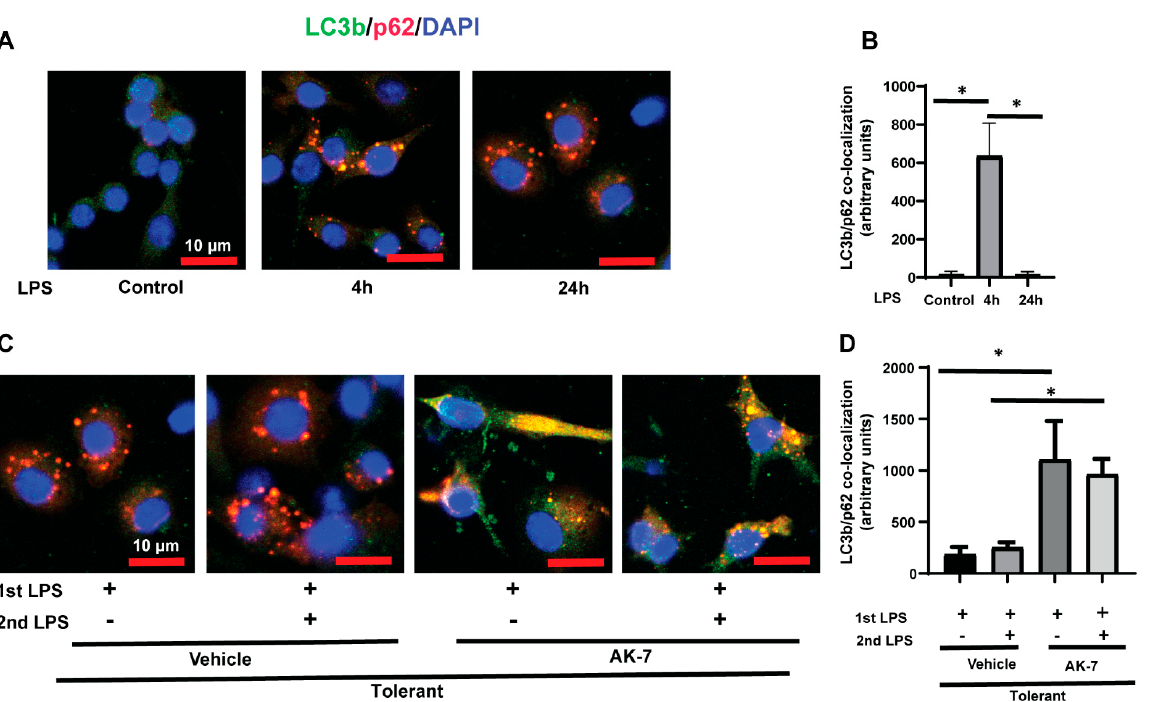
Figure 5. Elevated interaction of LC3b and p62 in sensitive but not tolerant macrophages. Stearic acid (free fatty acid: FFA)-exposed sensitive and tolerant RAW264.7 cell macrophages (RAW) were stimulated with or without LPS as indicated. ( A ) Representative Images of LC3b (green) and p62 (red) double immunostaining (yellow) in FFA-exposed sensitive and tolerant RAW cells following LPS stimulation as indicated. The yellow color indicates colocalization of LC3b and p62. ( B ) Fluorescence quantification of LC3b and p62 double immunostaining (yellow) in FFA-exposed sensitive and tolerant RAW cells. ( C ) FFA-exposed tolerant RAW cells were treated with SIRT2 inhibitor AK-7 (25 µM) or vehicle (DMSO; equal volume) and incubated further for 20 h and stimulated with or without LPS as indicated. Representative Images of LC3b (green) and p62 (red) double immunostaining (yellow) in FFA-exposed sensitive and tolerant RAW cells following LPS stimulation as indicated. ( D ) Fluorescence quantification of LC3b and p62 double immunostaining in FFA-exposed tolerant RAW cells in the presence or absence of AK-7. * p < 0.05.